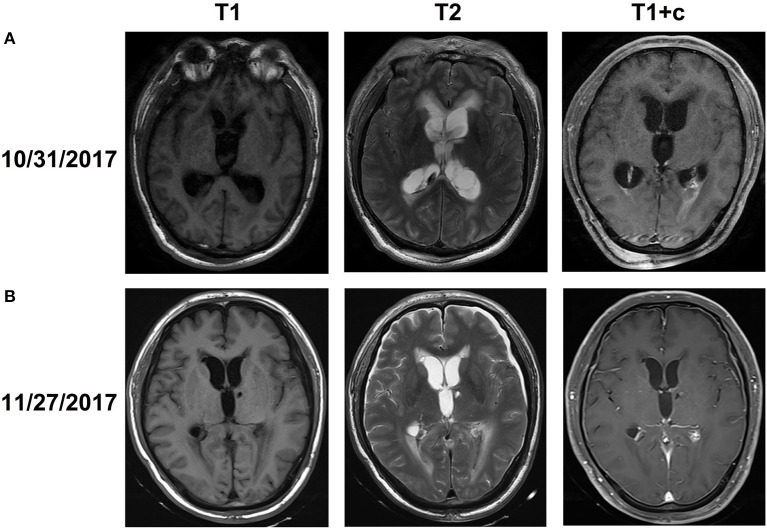
Brain MRI obtained before (A) and after (B) abscess clearance combined with tigecycline treatment (A). MRI on October 31, 2017 showed that interstitial cerebral edemas beside the ventricles and bilateral ventricular occipital horn enhancement along with hydrocephalus, which indicated signs of ventriculitis (B). MRI after abscess clearance combined with tigecycline treatment revealed the disappearance of the edemas, ventricular enhancement, and hydrocephalus.